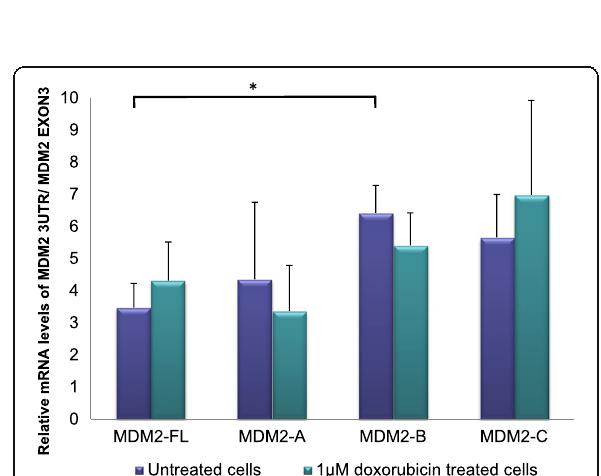
Fig. 3 Expression of endogenous MDM2 after transfection with the MDM2-splice variants. Relative mRNA levels of MDM2 3UTR / MDM2 EXON3 (i.e. corrected for transfection efficacy) measured after MCF-7 cells were transfected with MDM2-A, -B and -C and after cell sorting by GFP expression, untreated cells ( purple bars ) or 1 μ M doxorubicin treated ( green bars ) for 24 h. The experiment was repeated in triplicate, with three independent transfections. * = p ≤